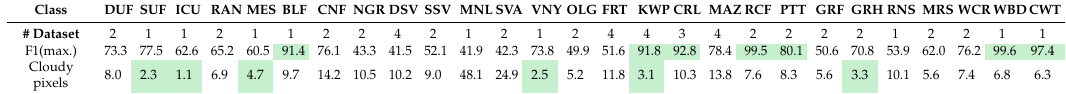
Table 5. Highest achieved F1 scores (%) per class, associated with the corresponding dataset and average cloud presence (%) in the reference